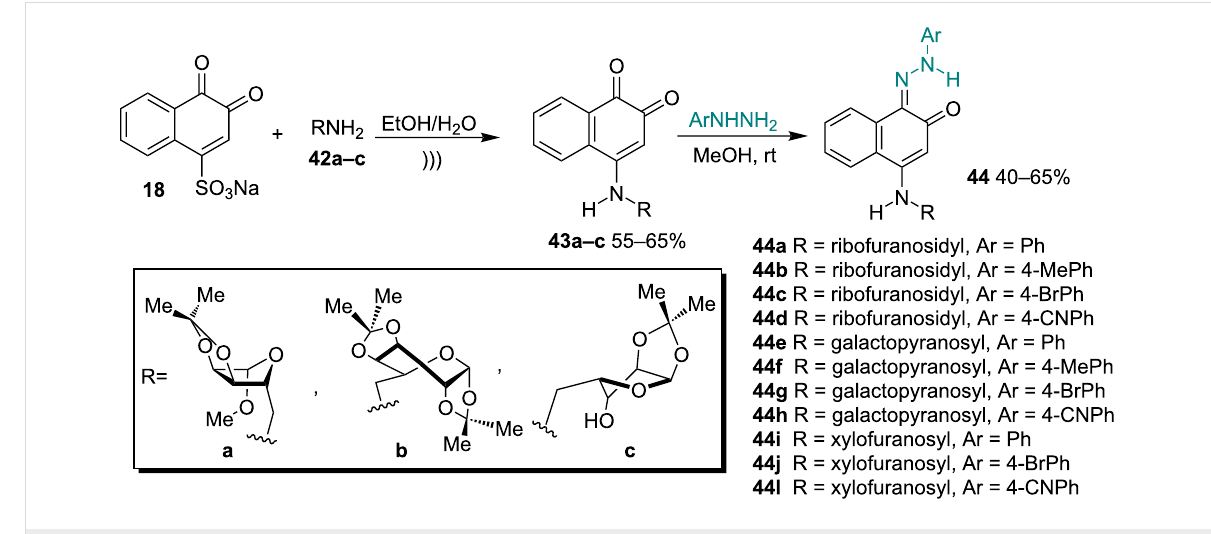
Scheme 12: Derivatives of 1,2-naphthoquinones obtained from β -NQS.